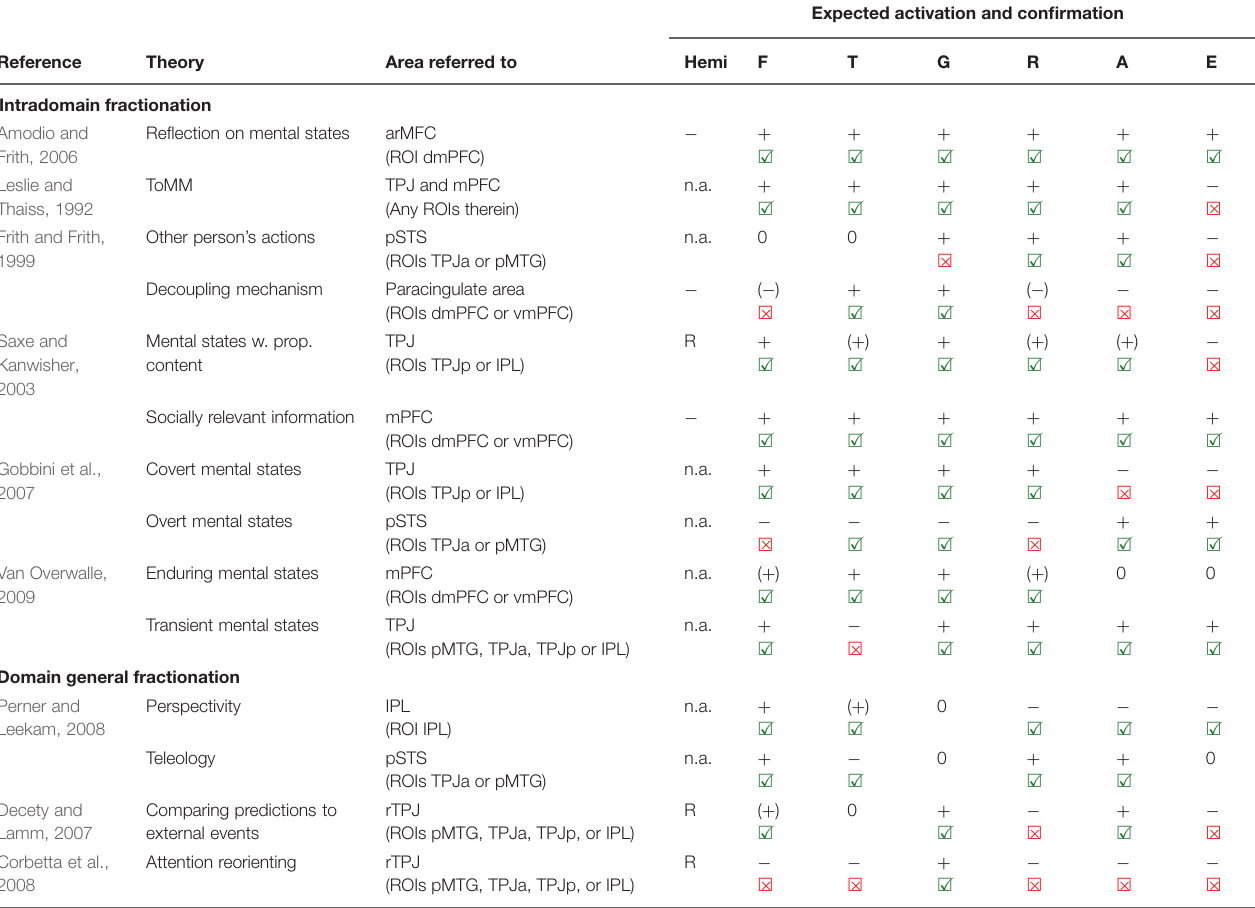
Expected activation and